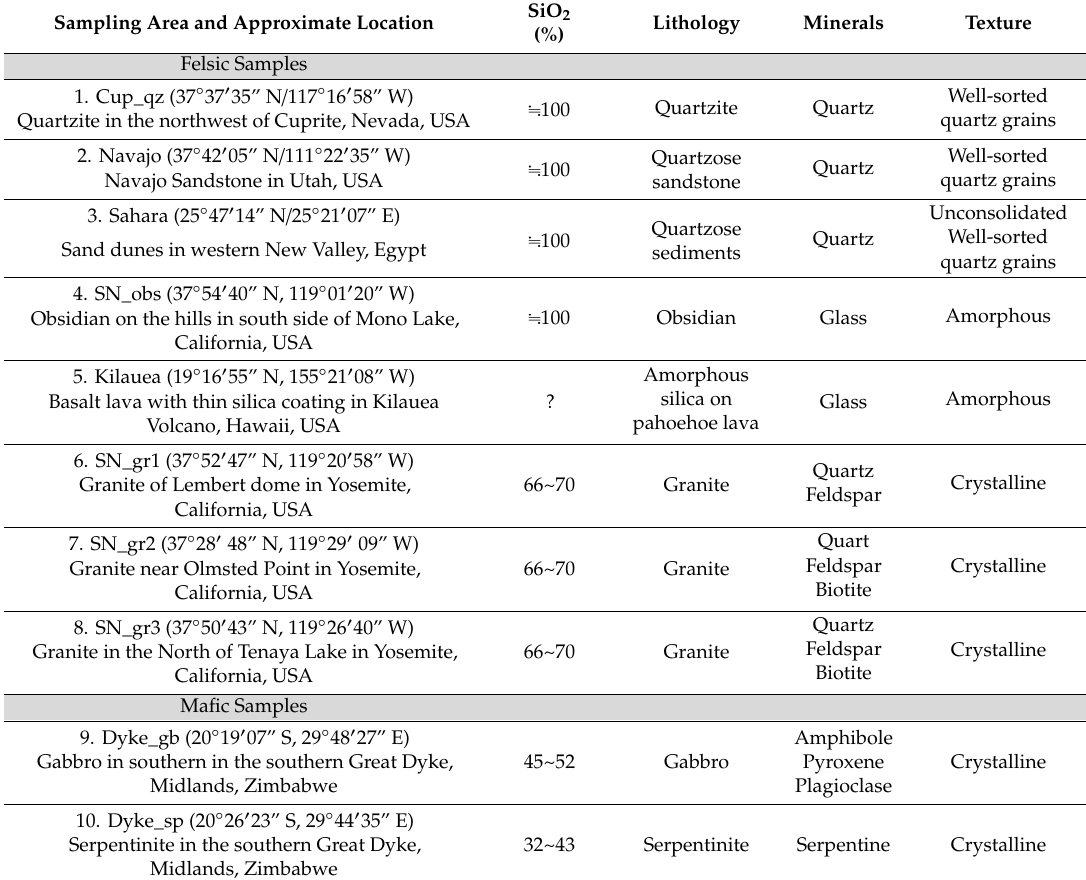
Table 2. Characteristics of the sampling areas for thermal infrared (TIR) emissivity spectra. Sampling Area and Approximate Location